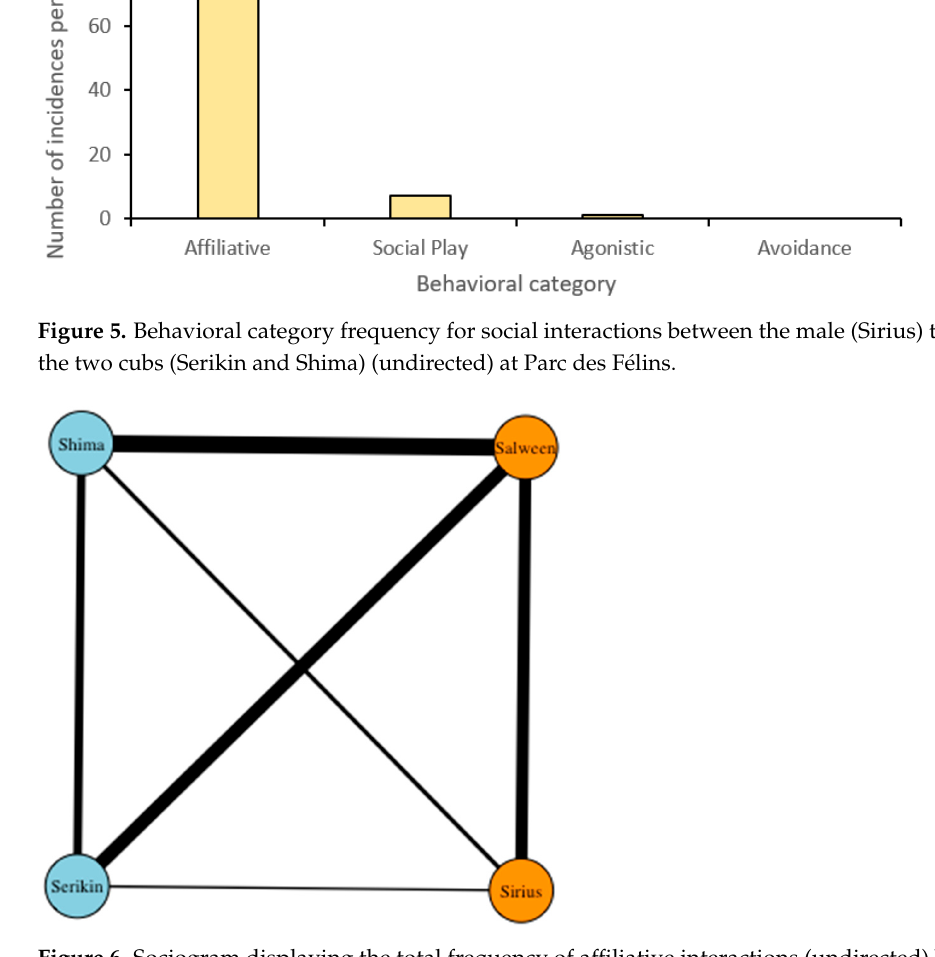
Figure 6. Sociogram displaying the total frequency of affiliative interactions (undirected) between the male, female, and cub tigers at Parc des Félins classed by age (orange = adult, light blue = cub). Edges are weighed based on total number of interactions between two nodes.